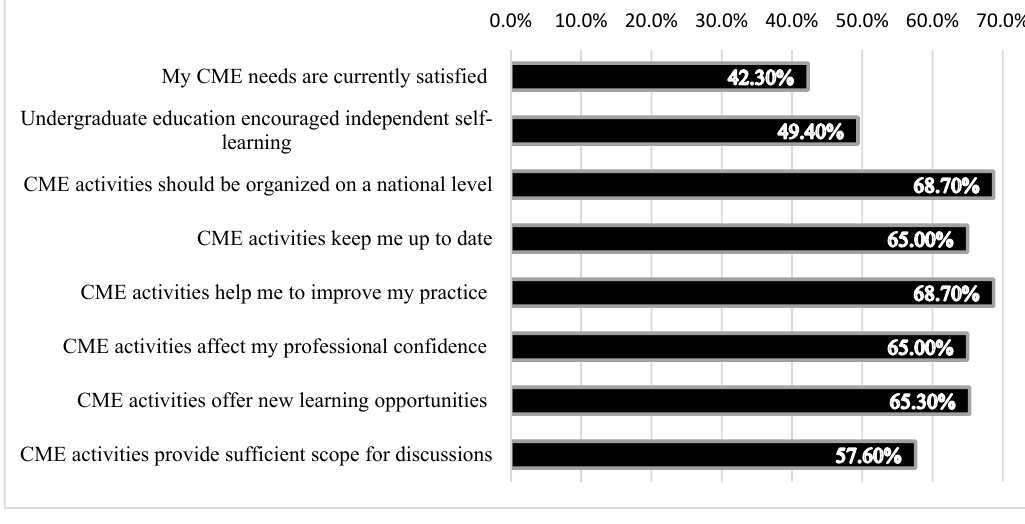
Figure 1. Resident’s beliefs about continuous medical education.